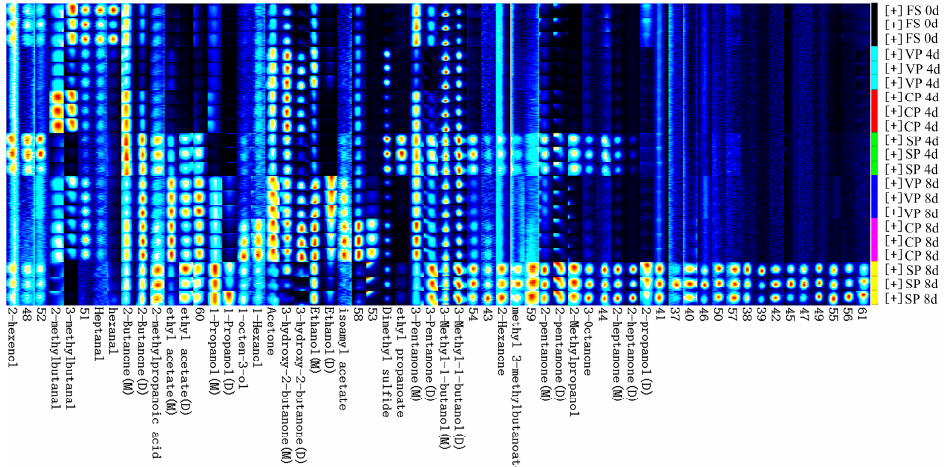
Figure 7. Fingerprint comparison of VOCs in the different pike-eel samples during chilled storage, as determined by GC–IMS. FS, fresh sample; SP, simple packaging; VP, vacuum packing; and CP, stable chlorine dioxide treatment combined with vacuum packing.